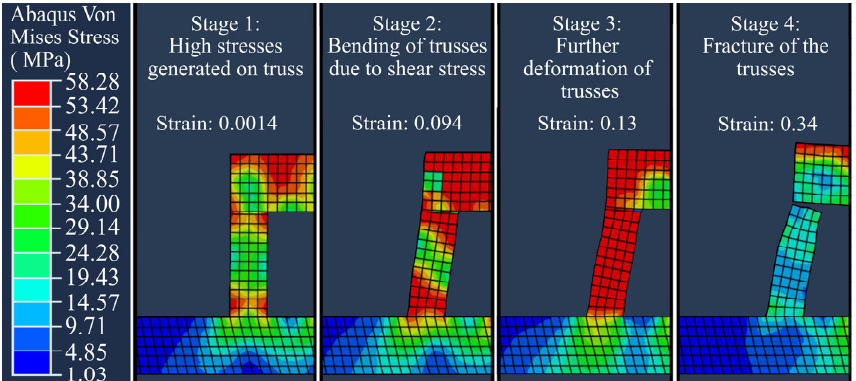
Figure 22. Typical bending progress of a truss until complete rupture via progress of von Mises stresses. The graph is taken from the unidirectional S0R72 part.